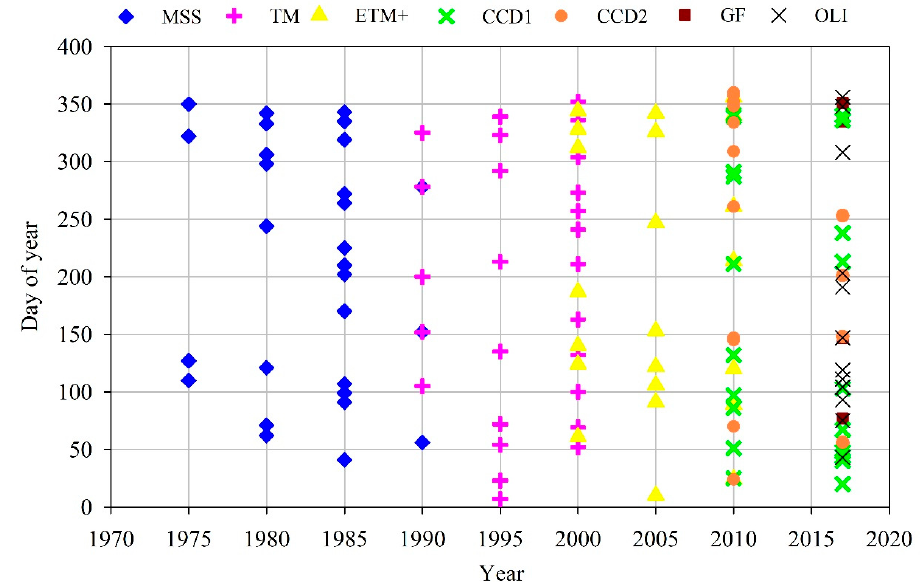
Figure 2. Acquisition dates of the satellite images used in this paper (Landsat multispectral scanner (MSS); Thematic Mapper (TM); Enhanced Thematic Mapper (ETM+); environment-1 and -2 satellite (CCD1, CCD2); High-resolution satellite imagery (GF) and Operational Land Imager (OLI)).